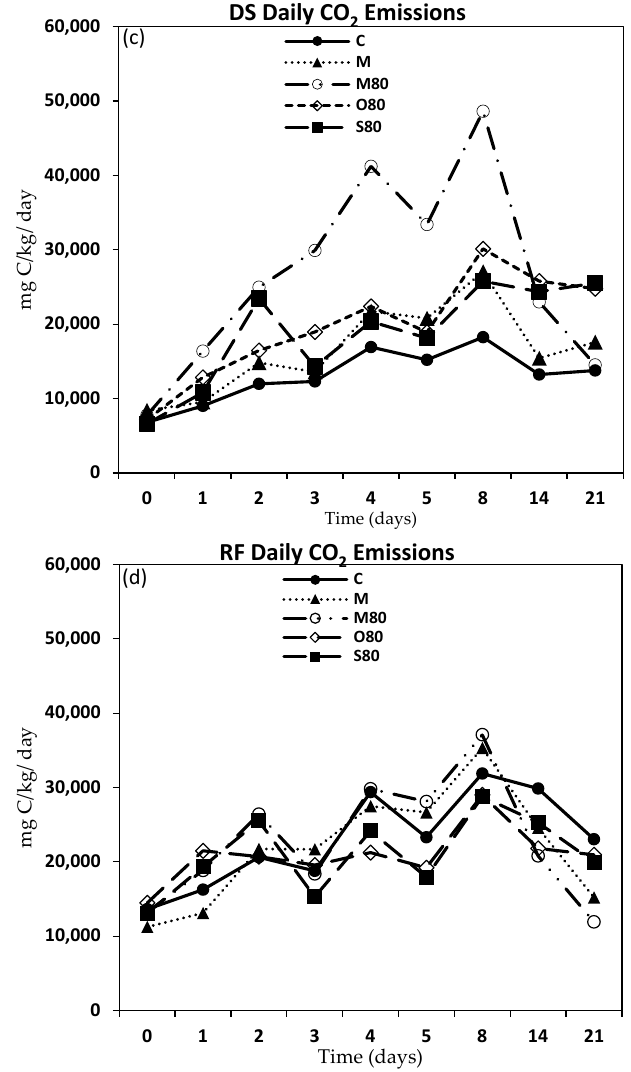
Figure 3. Mean (n = 3) daily emissions by treatments of N 2 O from the ( a ) Dry Savanna, DS and ( b ) Rainforest, RF soils and of CO 2 from the ( c ) Dry Savanna, DS and ( d ) Rainforest, RF soils. C = control, M = manure treatment, M80 = Manure + 80 kg N / ha, O80 = No manure + 80 kg N / ha S80 = soil pot microdosed with 80 kg N / ha without any vegetables.